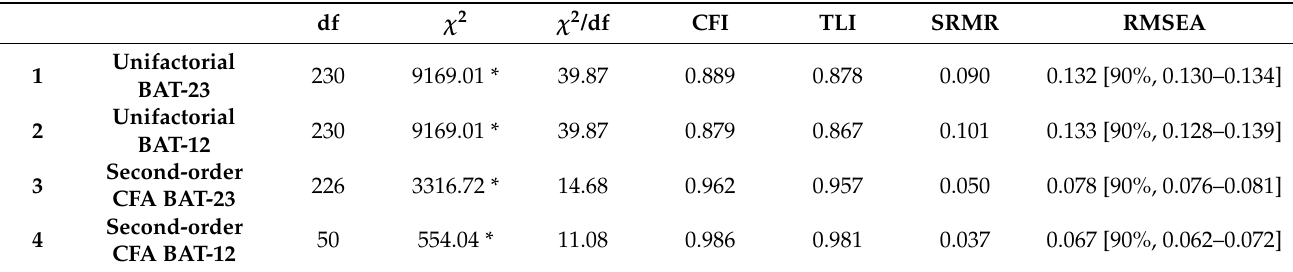
Table 1. Confirmatory factor analysis of BAT-23 and